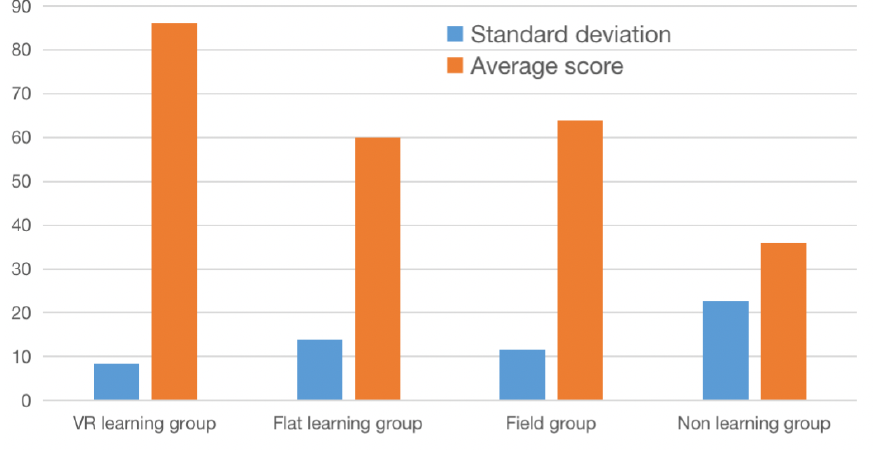
Figure 13. Comparison of the standard deviation and the average